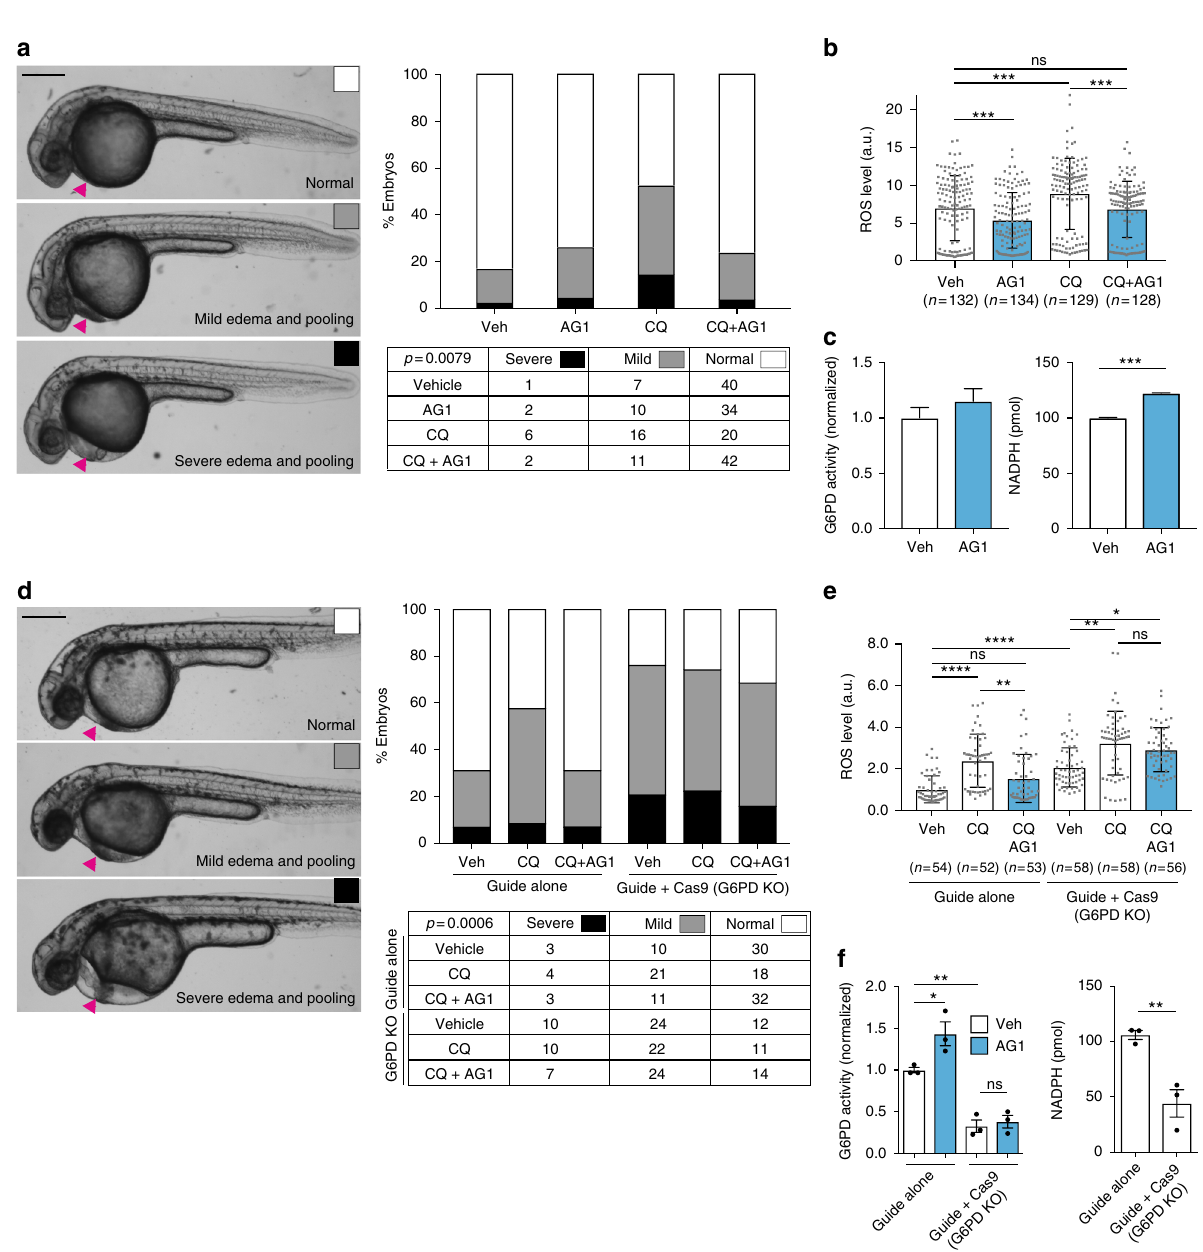
Fig. 4 AG1 attenuates ROS-induced pericardial edema in a G6PD-dependent manner. a Embryos were treated at 24 hpf with 1 μ M AG1 with and without chloroquine (CQ; 100 μ gmL − 1 ) and scored at 32 hpf. Representative phenotypic images of pericardial edema and pooling (magenta arrows) are provided on the left (scale bar: 300 μ m). Embryo orientation is lateral view, anterior left. Raw counts used for chi-square analysis and calculated p value are included in table below. b ROS levels in individual WT embryos from three independent clutches. Embryos were treated at 24 hpf for 5h before ROS measurement. Error bars represent mean±SD ( *** p <0.001, ns = not statistically signi fi cant, p >0.99, Kruskal – Wallis multiple comparison test, adjusted p value using Dunn ’ s test). c G6PD activity and NADPH levels were measured using the lysates of pooled embryos (from two independent clutches). Error bars represent mean±SEM ( *** p = 0.0003, two-tailed unpaired Student ’ s t -test). d Embryos were injected with either sgRNA targeting exon 10 of g6pd (Guide alone) or sgRNA + Cas9 protein (Guide + Cas9, G6PD KO (knockout)) to generate G6PD F0 crispants. Representative phenotypic images of pericardial edema and pooling (magenta arrows) are provided on the left (scale bar: 300 μ m). Treatment conditions are the same as in a . Raw counts used for chi-square analysis and calculated p value are included in table below. e ROS levels in individual embryos with sgRNA or sgRNA + Cas9 (G6PD KO) protein injection. Treatment conditions and the statistics are the same as in b ( * p = 0.0267, ** p <0.01, **** p <0.0001, ns = not statistically signi fi cant). f G6PD activity and NADPH levels were measured with lysates of pooled embryos from three independent experiments. Error bars represent mean±SEM of the replicate measurements ( * p <0.05, ** p <0.01, one-way ANOVA for G6PD activity measurement and two-tailed unpaired Student ’ s t -test for NADPH measurement). Veh: vehicle, KO: knockout, CQ: IPTG was added to induce the protein expression. After culturing at 28°C over- night, the bacteria were centrifuged, and the pellets were lysed by sonication in buffer containing 50 mM Tris (pH 7.4), 300 mM NaCl, 5% glycerol, 0.4mM PMSF, 1mg mL − 1 lysozyme, 0.1% Triton X-100 and protease inhibitor cocktail (Sigma P8340). G6PD was then puri fi ed by incubating the supernatant with TALON